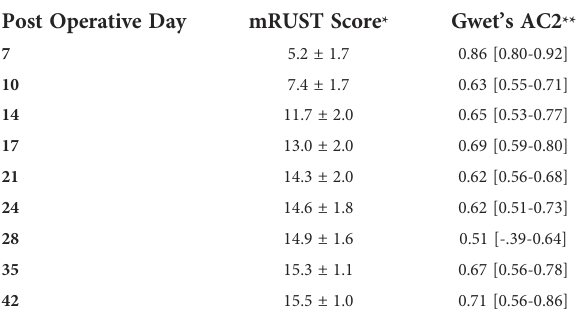
TABLE 1 mRUST scores and Gwet ’ s AC2 interrater analysis ratings based on postoperative day. mRUST Interrater Correlations Post Operative